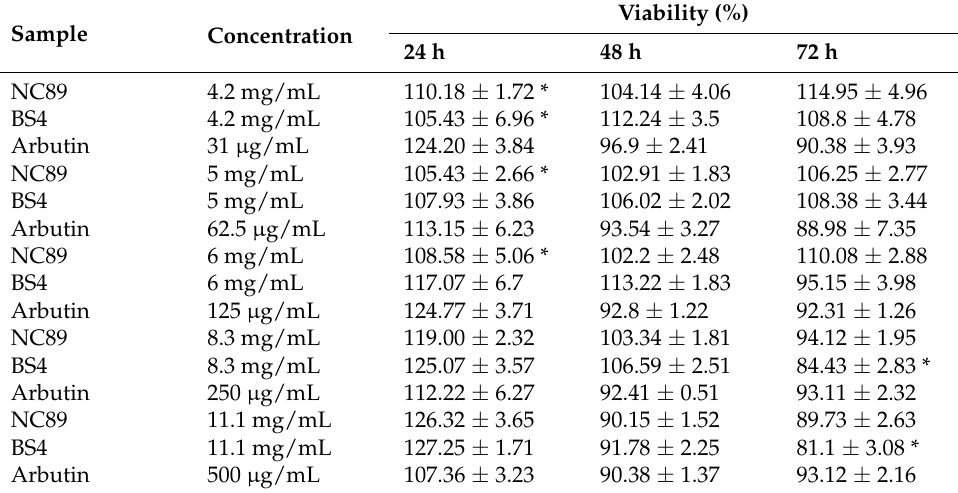
Table 4. Effect of tobacco seed oil on the proliferation in B16 cells.